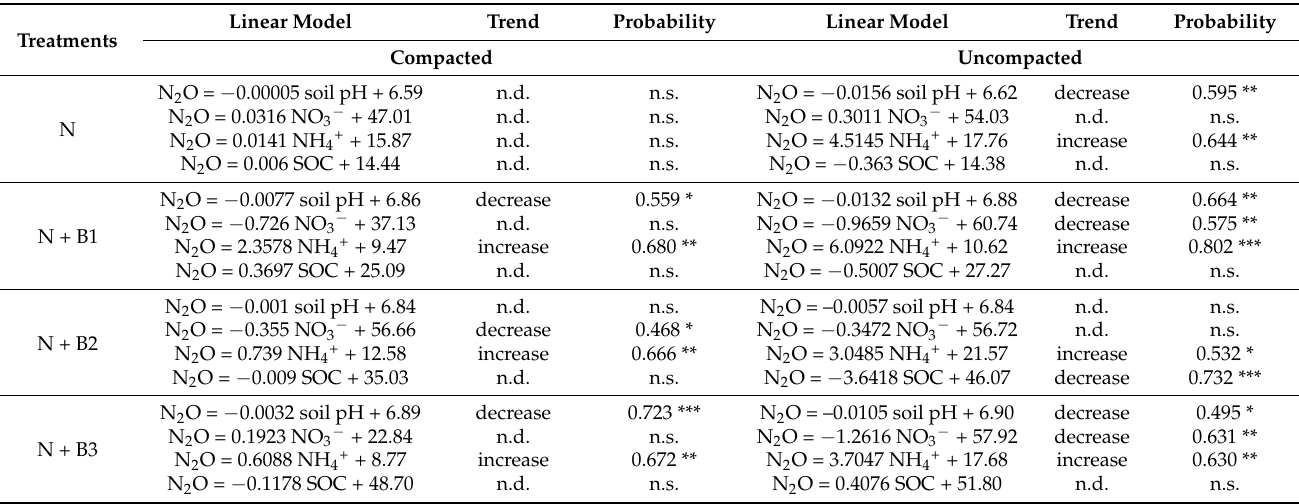
Table 4. Linear regression models between key soil parameters and N 2 O emissions in compacted and uncompacted Luvisol.